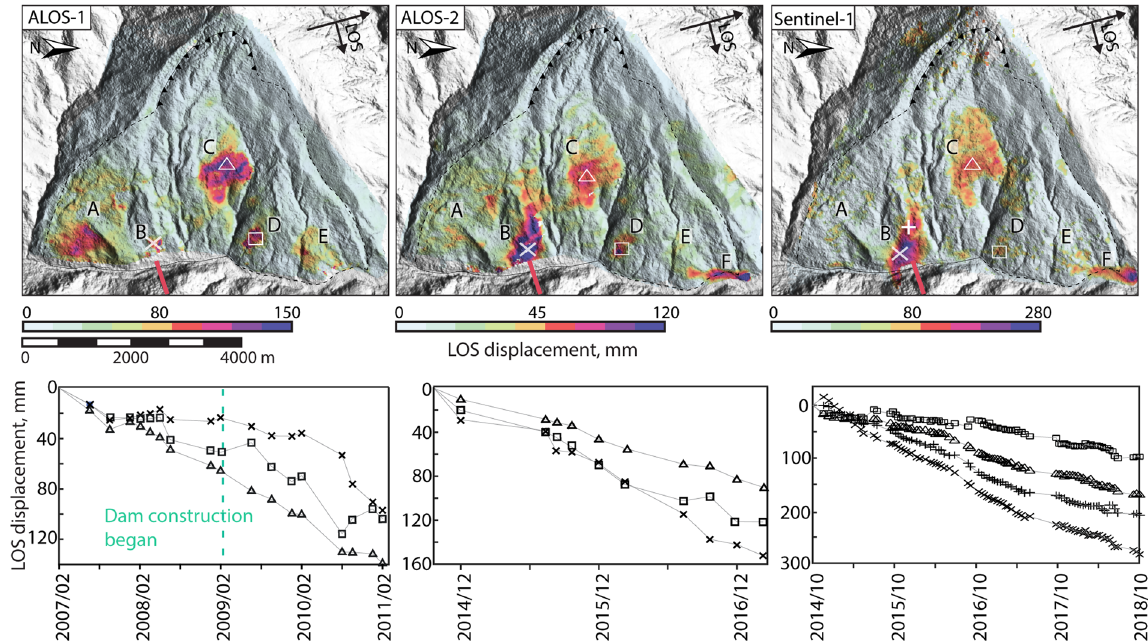
Figure 2. The top three panels show LOS cumulative displacements in the three sensors. Colour scales are different and non-symmetrical to highlight areas of highest displacements, with high variability in different sectors and in the three sensors. Letters indicate the sectors described in section 2. Left and centre panels at the bottom show the time series of ALOS-1 and ALOS-2 of three points in sectors B, C, and D. Sentinel-1 panel at the bottom right shows the time series for the same points as in the other two sensors, with the addition of one point in sector B (cross). Points shown in the corresponding panels above. Dam axis in red. ALOS-1 and ALOS-2 SAR imagery obtained from JAXA (Dataset ©JAXA/METI ALOS PALSAR L1.0 2007, 2008, 2009, 2010, 2011, 2014, 2015, 2016, accessed through https://auig2.jaxa.jp/openam/UI/Login, 2016 and 2017). Copernicus Sentinel data [2014, 2015, 2016, 2017, 2018] accessed through the ESA Copernicus open access hub https://scihub.copernicus.eu/dhus/#/home, 2017, 2018. InSAR processing done with the software SARScape from